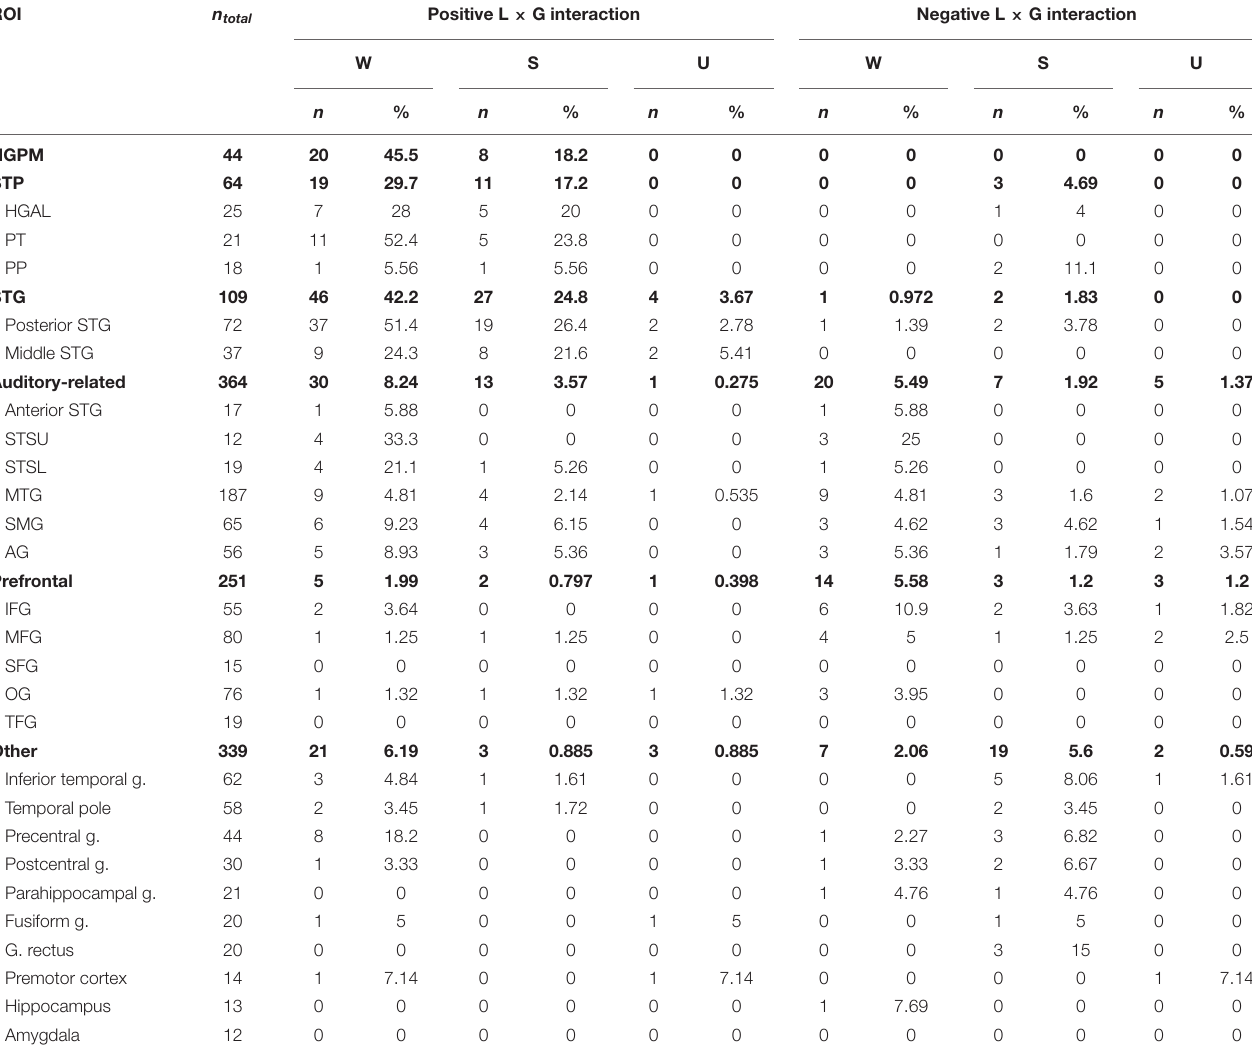
TABLE 2 | Numbers and percentages of sites with significant positive and negative L × G interactions across arousal states. ROI n total Positive L × G interaction Negative L × G interaction W